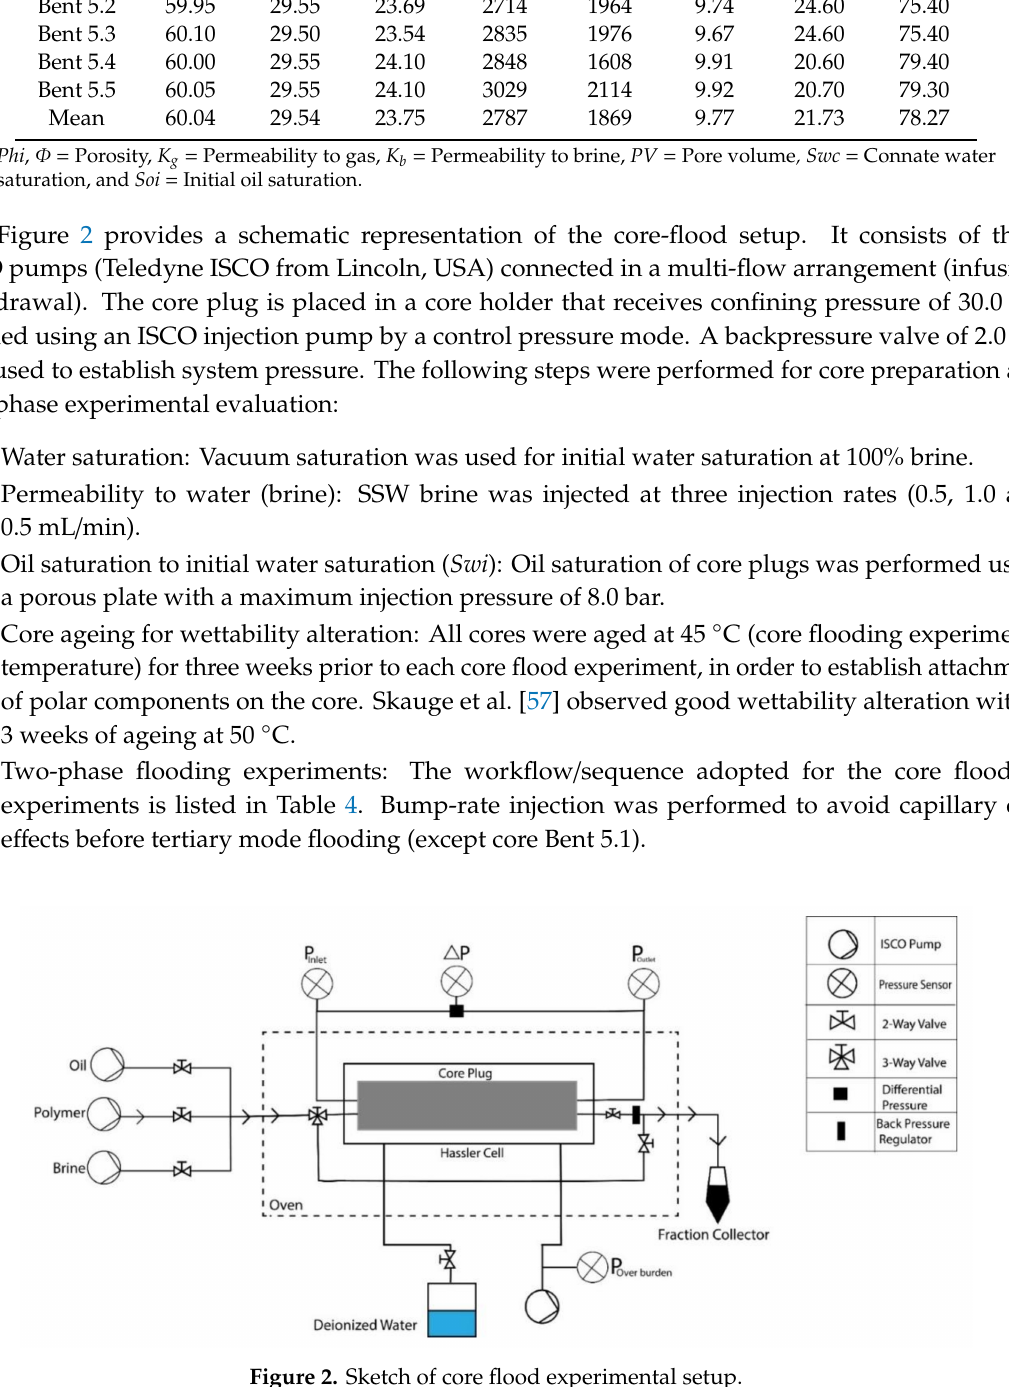
Figure 2. Sketch of core flood experimental